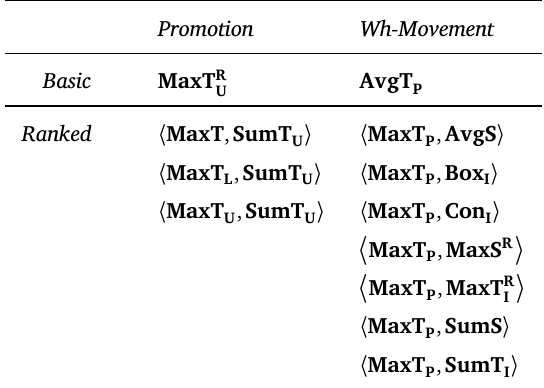
Table 3: List of empirically viable complexity